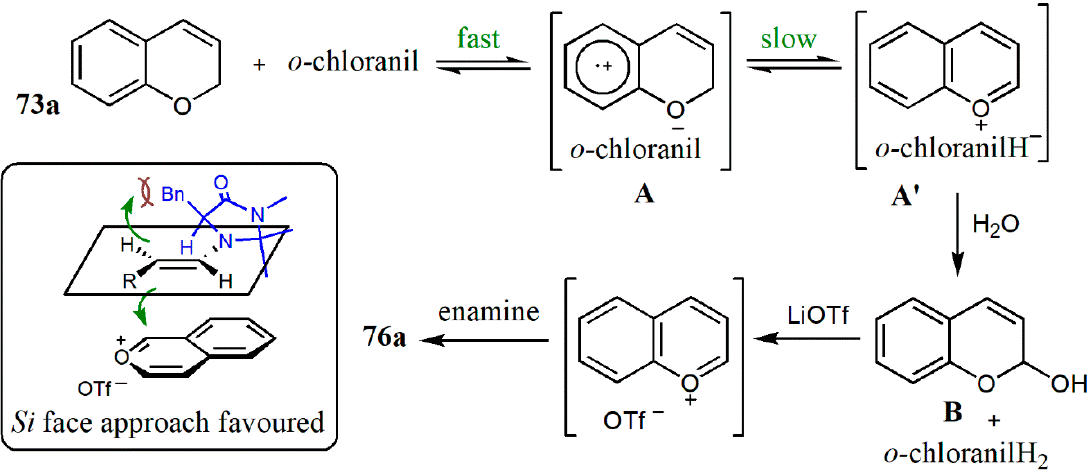
Figure 22. Proposed pathway for the CDC of 2 H- chromenes and aldehydes.